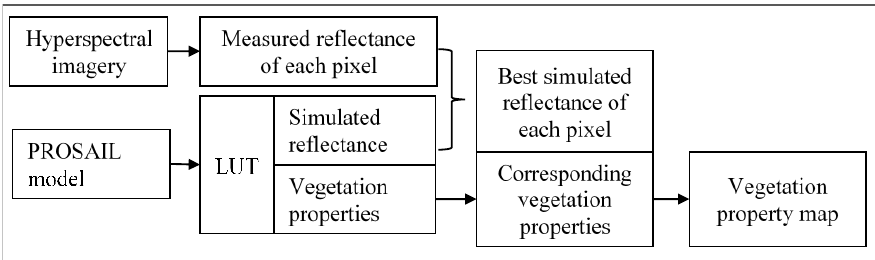
Figure 4. A brief workflow of look up table (LUT) for inverting PROSAIL.